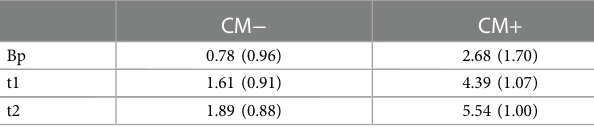
TABLE 3 Descriptive data M(SD) of children ’ s emotional problems at every measuring point with CM+ and CM −